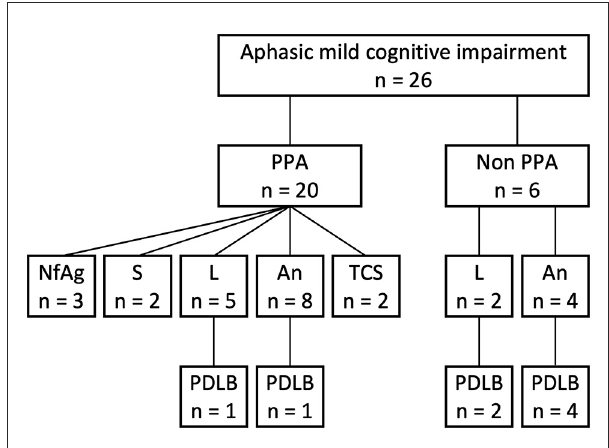
FIGURE1 Flowchart of participant selection. An, anomic; L, logopenic; NfAg, non-fluent/agrammatic; PDLB, prodromal dementia with Lewy bodies; PPA, primary progressive aphasia; S, semantic; TCS, transcortical sensory.